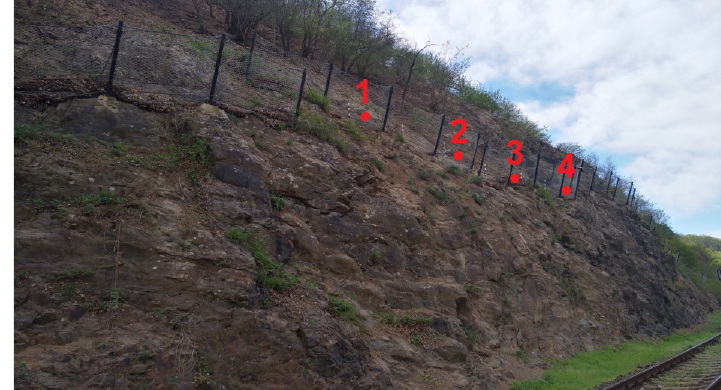
Figure 11. View of the installed protective fences above the